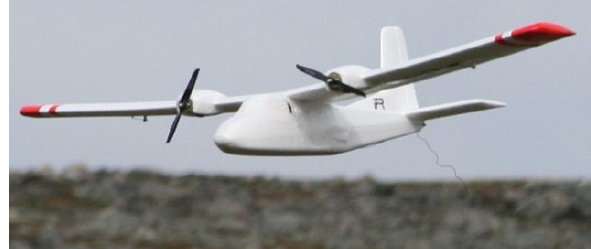
Figure 1: Used fixed-wing UAV platform in flight